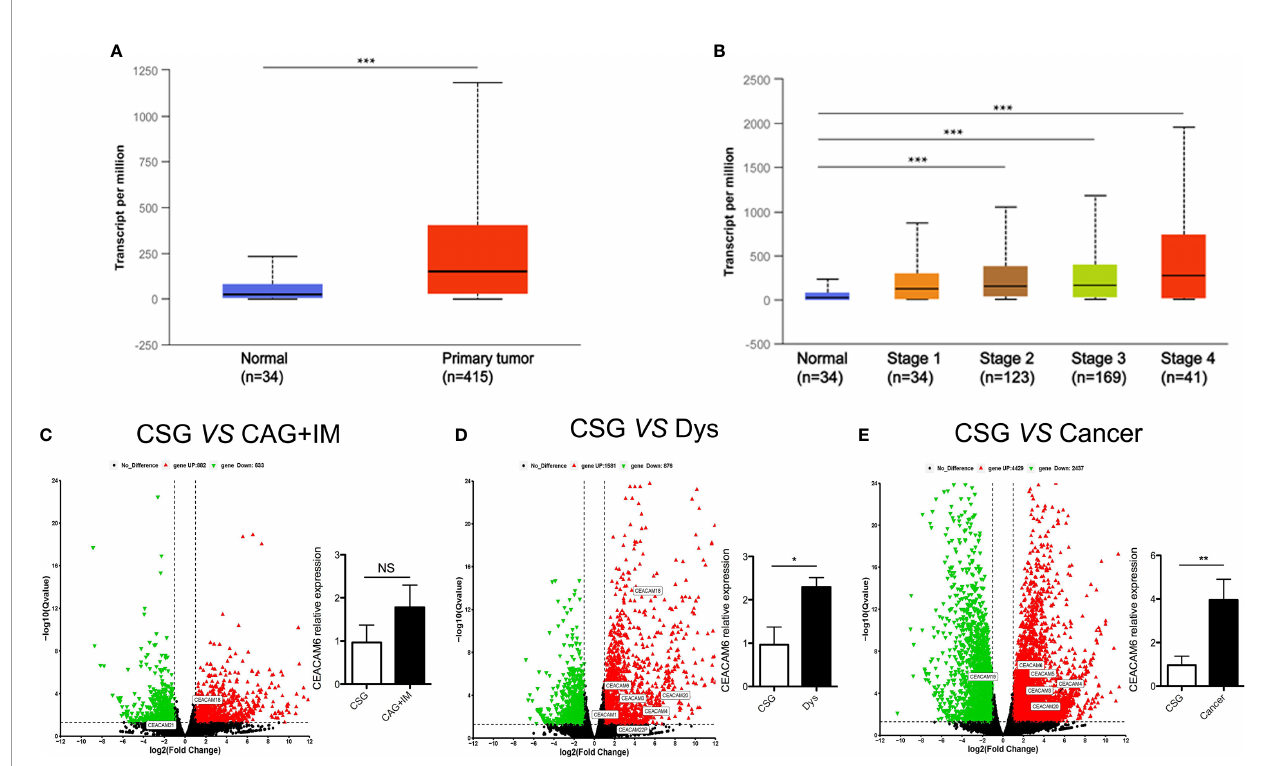
FIGURE 1 | CEACAM6 mRNA expression in the gastric mucosa from normal to cancer. (A) Searched the CEACAM6 mRNA expression in the normal and stomach adenocarcinoma tissues in TCGA dataset through UALCAN (http://ualcan.path.uab.edu) website, normal (n=34), primary tumor (n=415). (B) Searched the CEACAM6 mRNA expression in the stomach adenocarcinoma tissues with different clinic stage in TCGA dataset, normal (n=34), stage 1 (n=34), stage 2 (n=123), stage 3 (n=169), stage 4 (n=41). The volcano map showed the deregulated mRNAs in CAG+IM (C) , Dys (D) and Cancer (E) , the red triangles represented up regulated mRNAs and the green triangles represented down regulated mRNAs (P<0.05), the deregulated mRNAs had no signi fi cant differences were showed in the black triangles, the up or down regulated CEA family members were veri fi ed by RT-qPCR and labeled in the map. The histograms in the volcano map showed the veri fi cation of CEACAM6 mRNA expression. *P < 0.05, **P < 0.01, ***P < 0.001, NS, no signi fi cance. CSG, Chronic Super fi cial Gastritis; CAG+IM, Chronic Atrophic Gastritis (CAG) + Intestinal Metaplasia (IM); Dys, Dysplasia; Cancer, Gastric